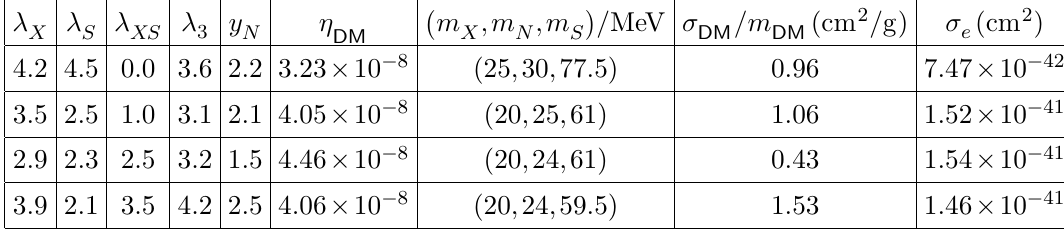
> 1 in the a SIMP N